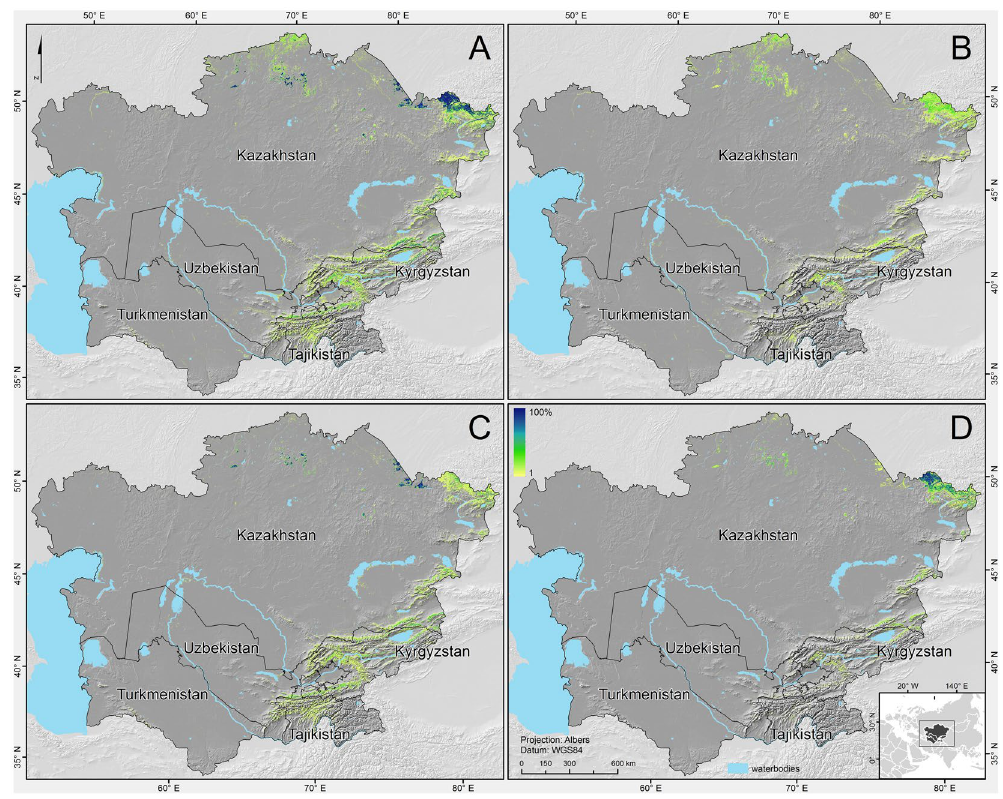
Figure 2. Forest cover percentage with ( A ) all forest types, ( B ) deciduous, ( C ) evergreen, and ( D ) mixed forest. This figure was produced using ArcGIS